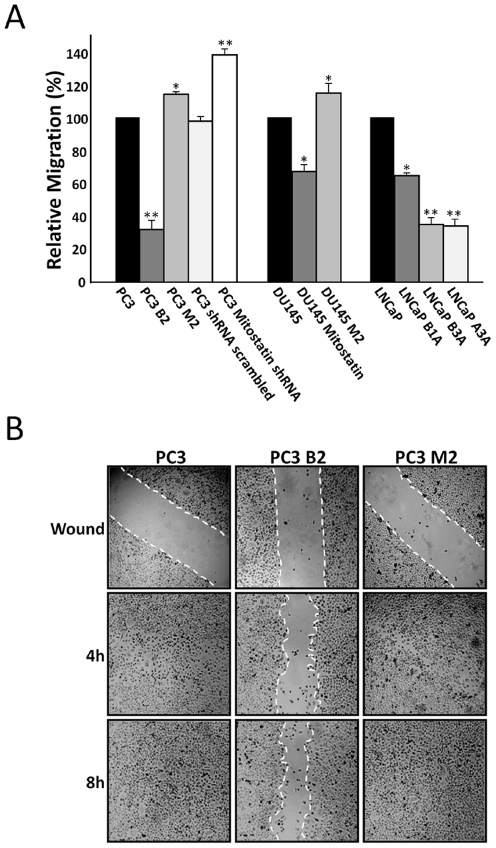
Mitostatin inhibits in vitro migration of prostate cancer cells.
A
and
 B: Mitostatin over-expressing clones showed reduced migratory properties compared to parental cells. Migration was assessed through migration (A) and the wound healing assays (B). Cells with down-regulation of the endogenous Mitostatin protein (PC3 M2, PC3 Mitostatin shRNA, and DU145 M2) showed an increased malignant behavior. Data are expressed as percentage of migration versus parental cells. Columns, representative images of triplicates from three independent experiments; bars, SEM. * P<0.05; ** P<0.01.